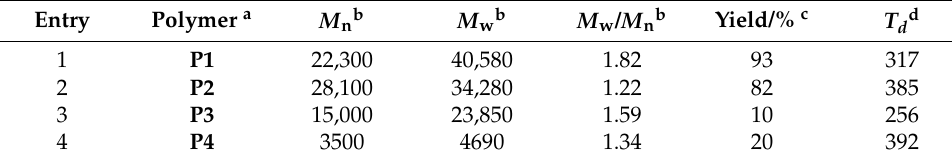
Table 1. Results of the polycondensation and the thermostability of P1 – P4 .